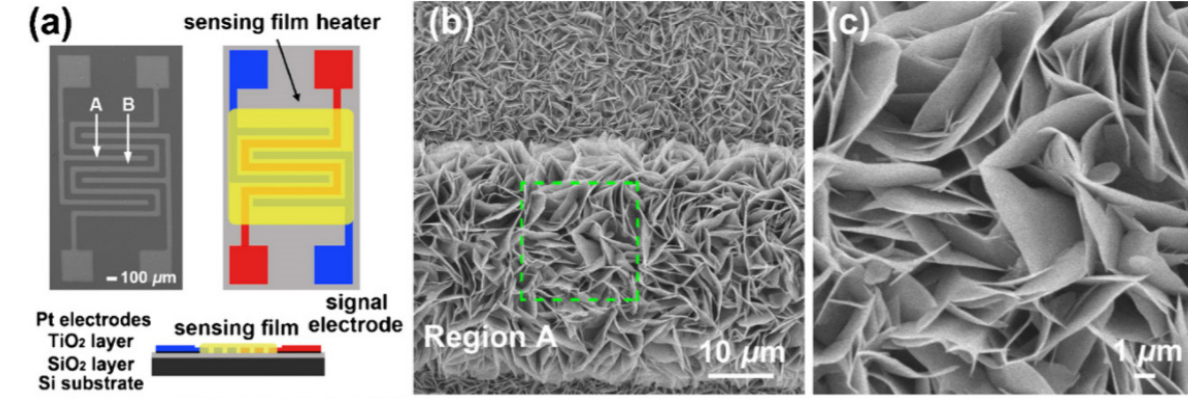
Figure 25. ( a ) Schematic diagrams of the different views for the sensor platform; ( b , c ) FE-SEM images of ZnO nanosheets (NSs) having a 3D structure taken from different regions in the sensor platform. Reprinted with permission from [161]. Copyright 2012: Elsevier.